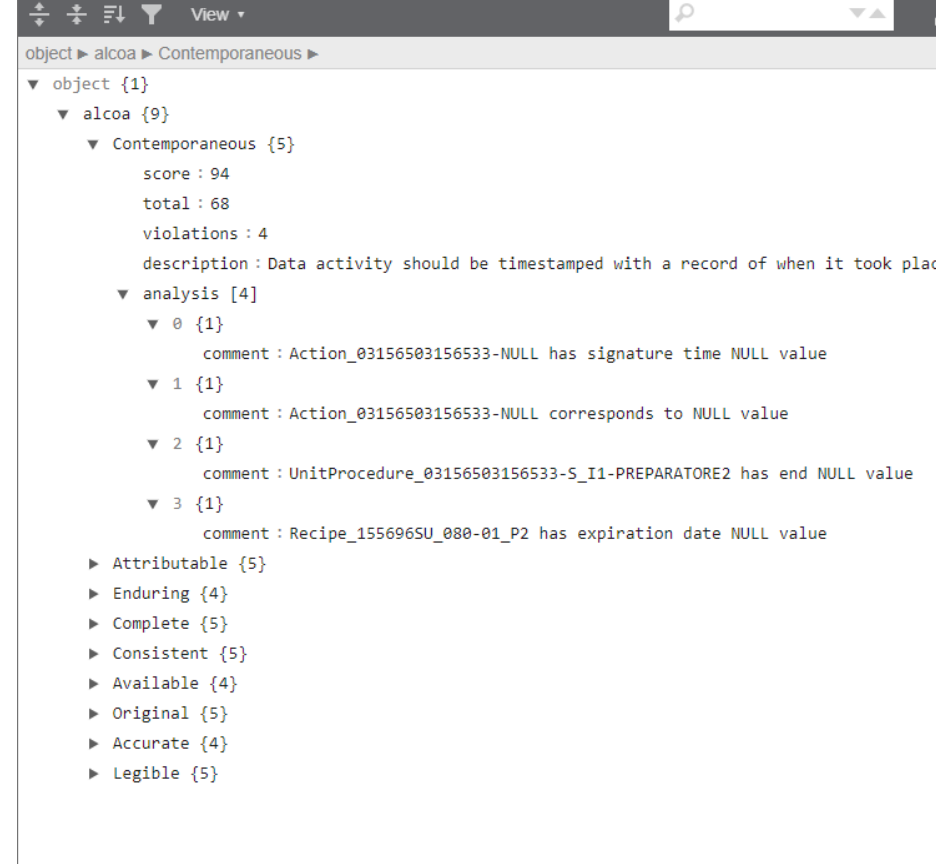
Figure 6. ALCOA assessment report for Contemporaneous